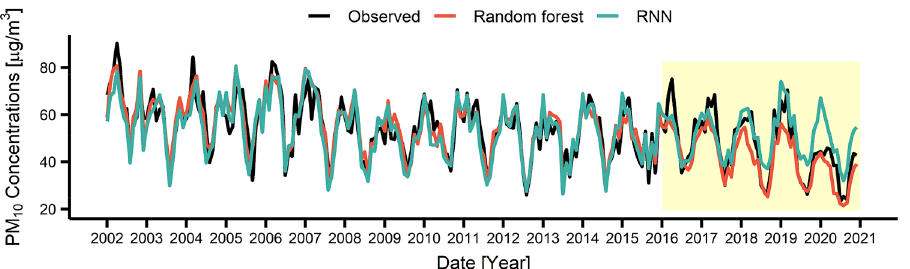
Figure 6. Monthly concentrations of observed and predicted values by using RNN and RF for PM 10 . The area shaded in yellow showed the period when the Euro 6 was applied.